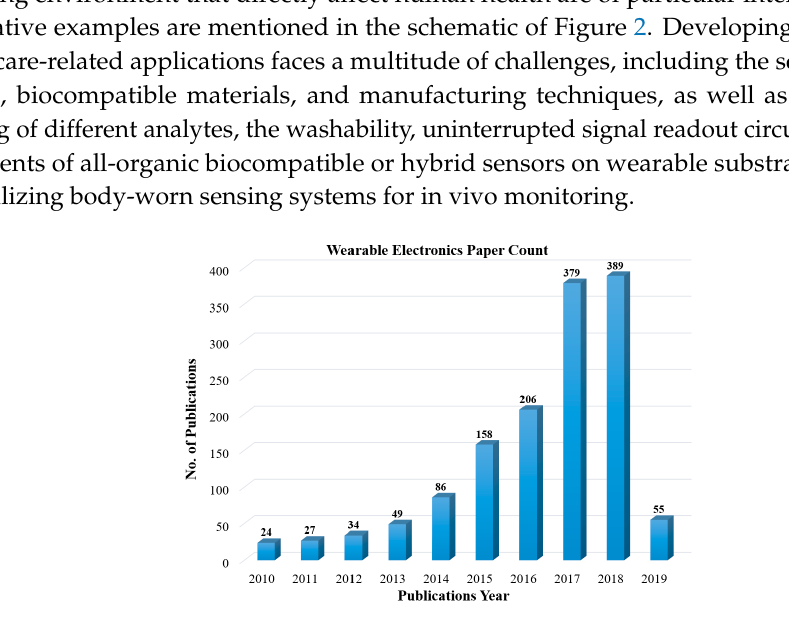
Figure 1. Number of publications per year with titles including wearable electronics (Source: NCBI (National Center for Biotechnology Information)).